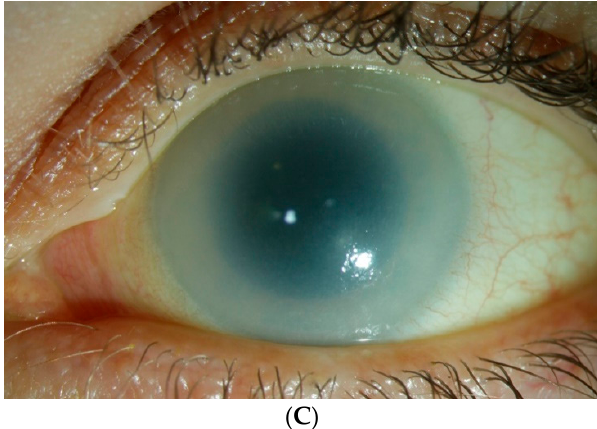
Figure 4. ( A ) Corneal clouding in MPS VI. ( A ) shows a 17-year-old male with enzyme replacement therapy (ERT). ( B ) shows an 11-year-old female with ERT. ( C ) shows a 38-year-old female with no systemic